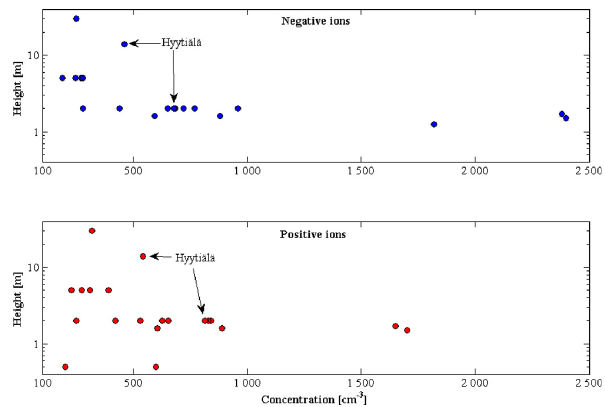
Fig. 4. The mean concentrations as a function of height from the ground. Red colour indicates positive and blue colour negative po- larity. Data at 30m is from